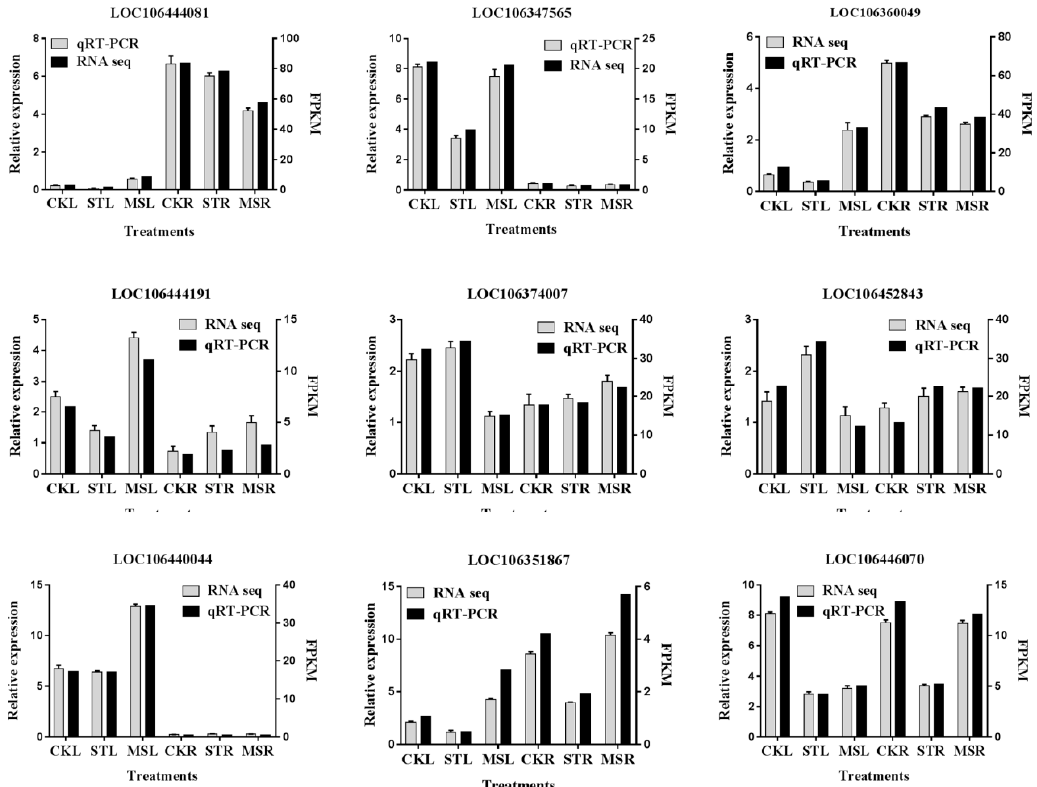
Figure 5. Validation of nine randomly selected genes by Quantitative Real-Time PCR (qRT-PCR). The mRNA expression levels were normalized to the expression level of ACTIN , and the means from three biological replicates are shown. The accumulated transcripts of the candidate genes in FPKM (Fragments Per Kilobase of transcript per Million mapped reads, right y-axis) were got from the RNA-seq data.